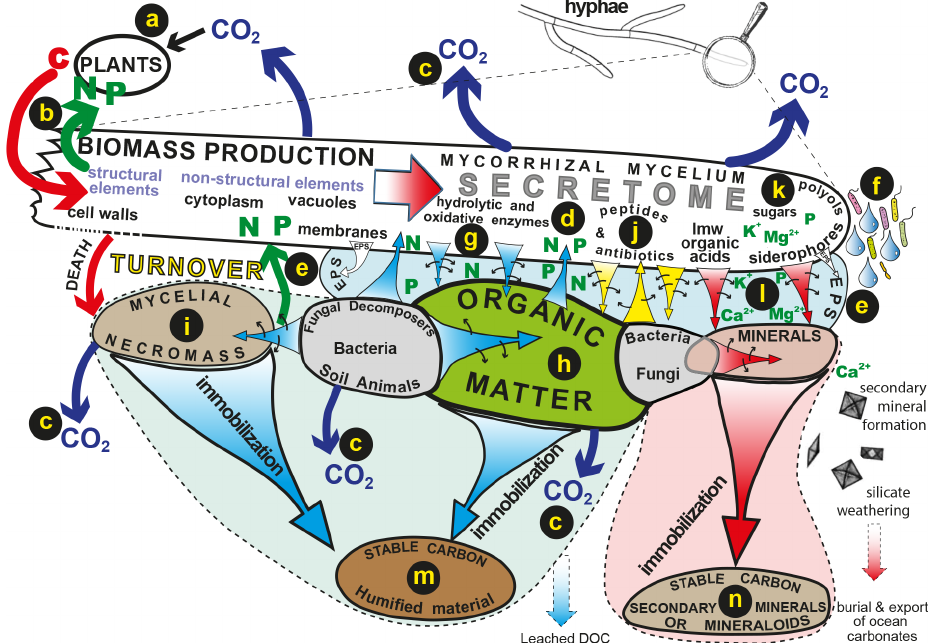
Figure 2. The flow of plant-derived carbon through fungal hyphae to organic and inorganic substrates drives biogeochemical processes such as decomposition and weathering and influences patterns of C release and sequestration into stable organic and inorganic forms. Carbon is assimilated by plants (a) and transferred directly to symbiotic mycorrhizal hyphae that transfer nutrients mobilised by the hyphae back to their hosts (b). Products of mycelial respiration are released to the atmosphere (c). The fungal secretome (d) consists of different labile compounds that can be translocated to different organic or inorganic substrates. These compounds may be released into an extracellular polysaccharide matrix (e) or as droplets that condition the hyphosphere, facilitating interactions with bacteria (f). Hydrolytic and oxidative enzymes (g) mobilise N and P from plant-derived organic substrates (h) or microbial necromass (i). Peptides and antibiotics play important roles in signalling and influencing microbiome structure (j), sugars and polyols maintain osmotic gradients and hyphal turgor (k), and low- molecular-weight organic acids and siderophores influence the mobilisation of P and base cations from minerals (l). Long-term sequestration and stabilisation of carbon can take place in recalcitrant organic substrates (m) and secondary minerals and mineraloids (n) (reproduced with permission; Finlay and Clemmensen,